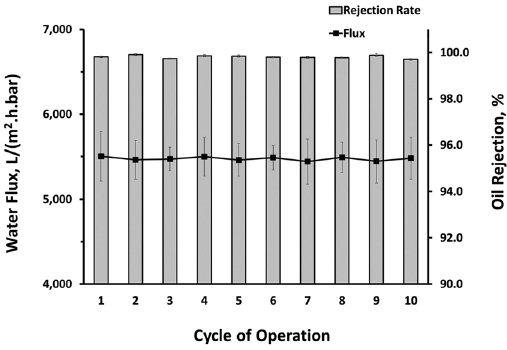
Figure 6. Permeate water flux and oil rejection ratio of the MWCNT-MNO 2 over period of 10 operating